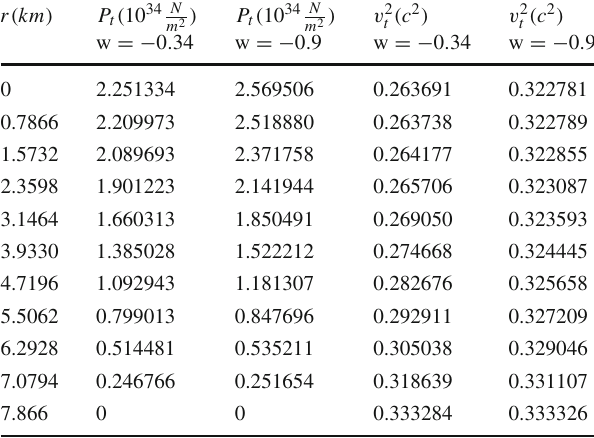
Table 2 Values of the hydrostatic variables for the star Her